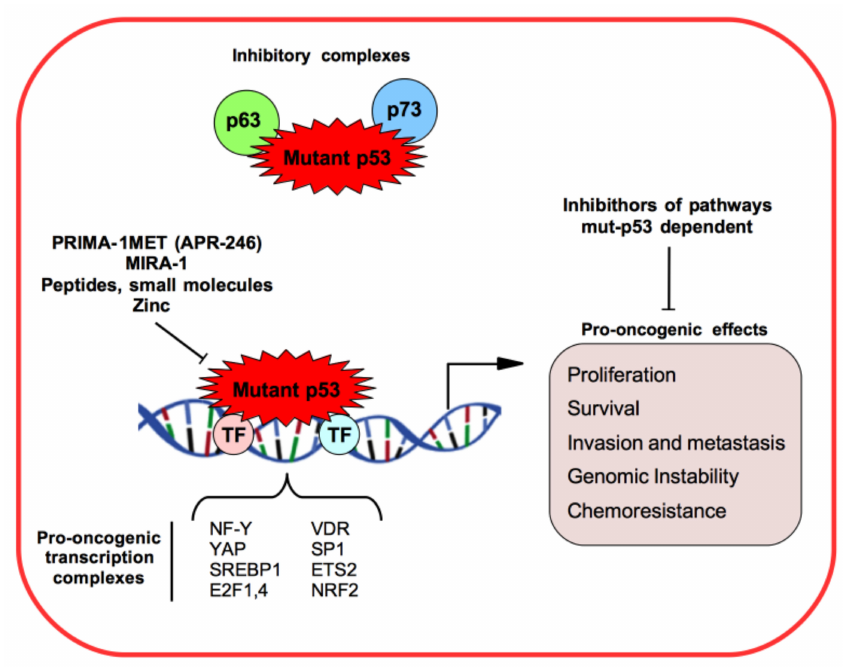
Figure 1. Mutant p53 (mut-53) gain-of-function mechanisms and pro-oncogenic e ff ects in cancer